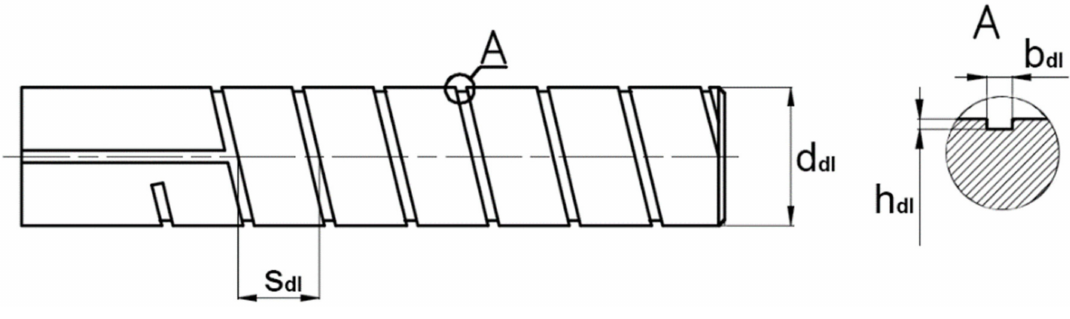
Figure 14. Spiral choke [5].